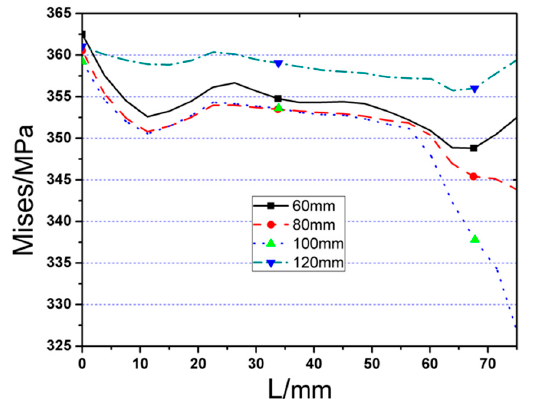
Figure 9. The Von Mises stress distribution along welding seam length (start from edge to middle of welding seam) of RA series FE joint models.